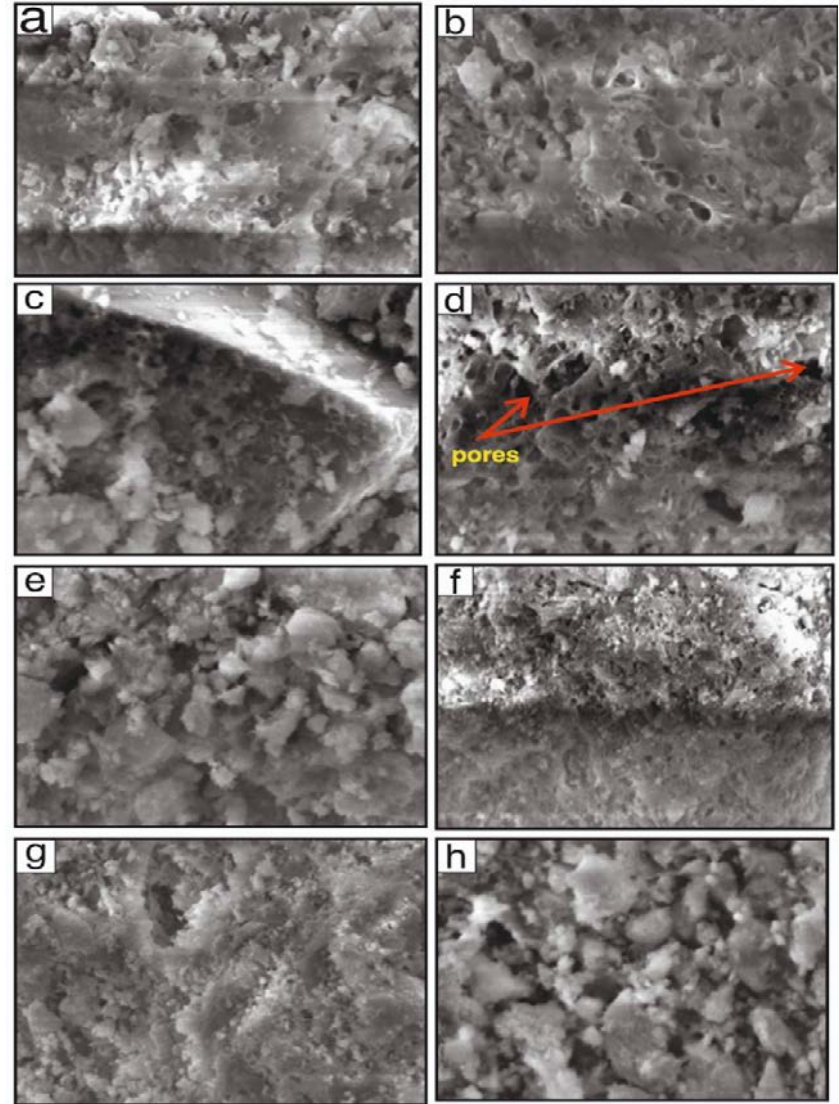
Fig. 5: Scanning electron microscopy images of fired bricks: a (indicator), b (B1), c (B2), d (B3), e (B3,5), f (B4), g (B5), and h